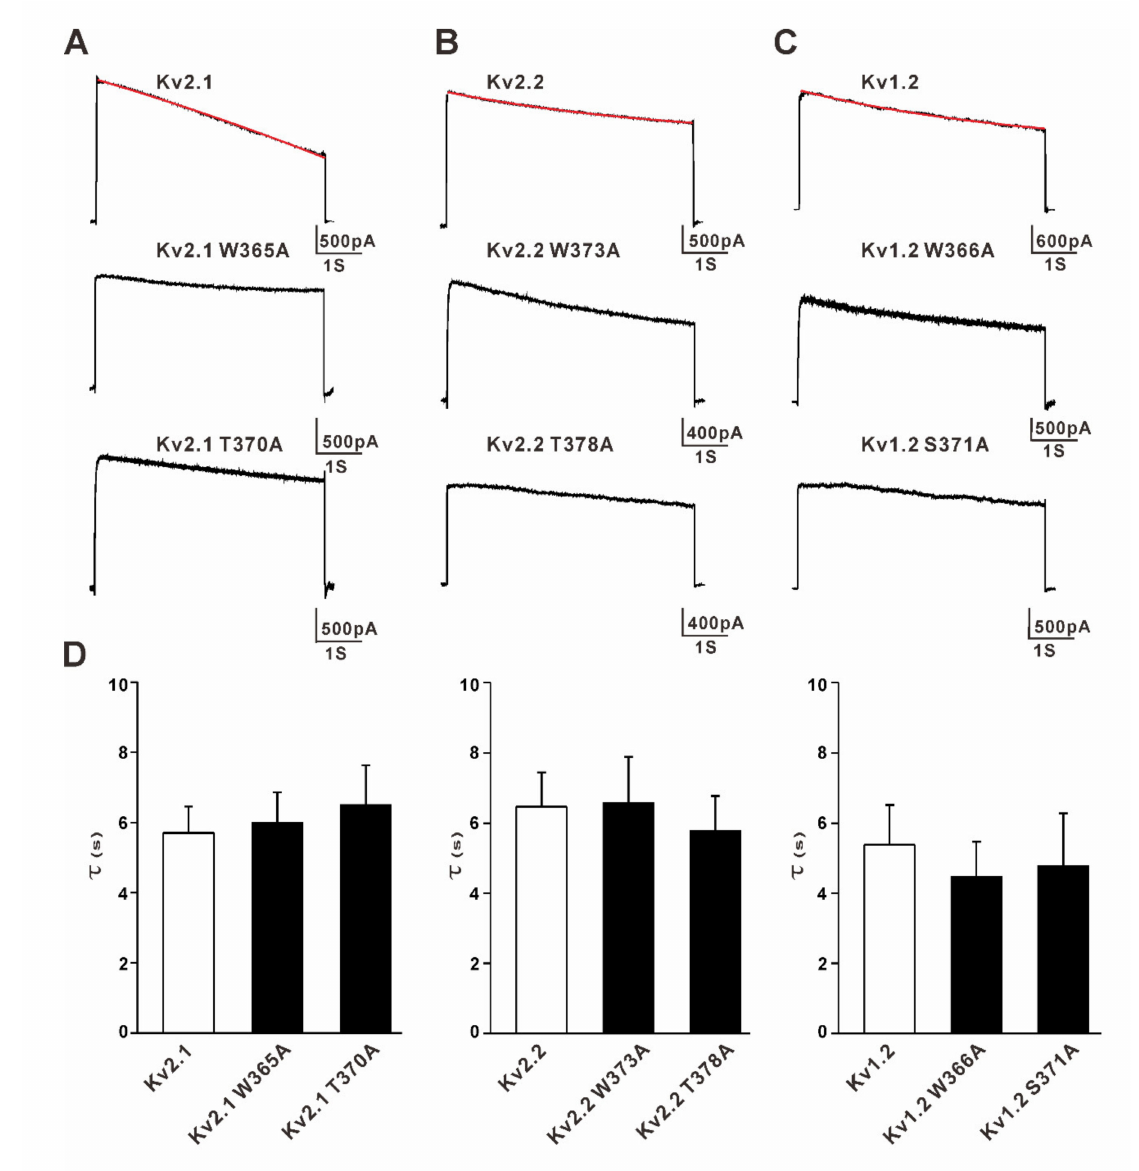
Figure 2. Effects of the mutation of the time constants of the inactivation of the Kv2.1, Kv2.2, and Kv1.2 channels. The inactivation time constants for the wild-type and mutant Kv channels were determined by fitting a 5-s depolarization at +20 mV with single exponentials. Red lines show the representative fitting trajectories of the current traces. ( A ). Representative currents for the Kv2.1 wild-type, W365A, and T370A mutant channels (5-s pulses from − 100 mV to 20 mV) ( B ). Representative currents for the Kv2.2 wild-type, W373A, and T378A mutant channels. ( C ) Representative currents for the Kv1.2 wild-type, W366A, and S371A mutant channels. ( D ) Comparison of the time constants of the inactivation of